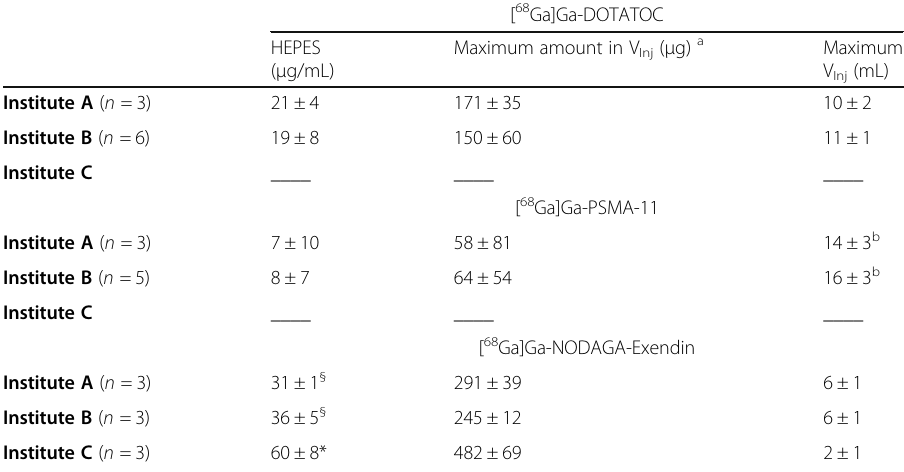
Table 3 Amounts of HEPES in different 68 Ga-radiopharmaceuticals obtained from different institutes and analyzed by the HPLC method ( n = the number of samples from different